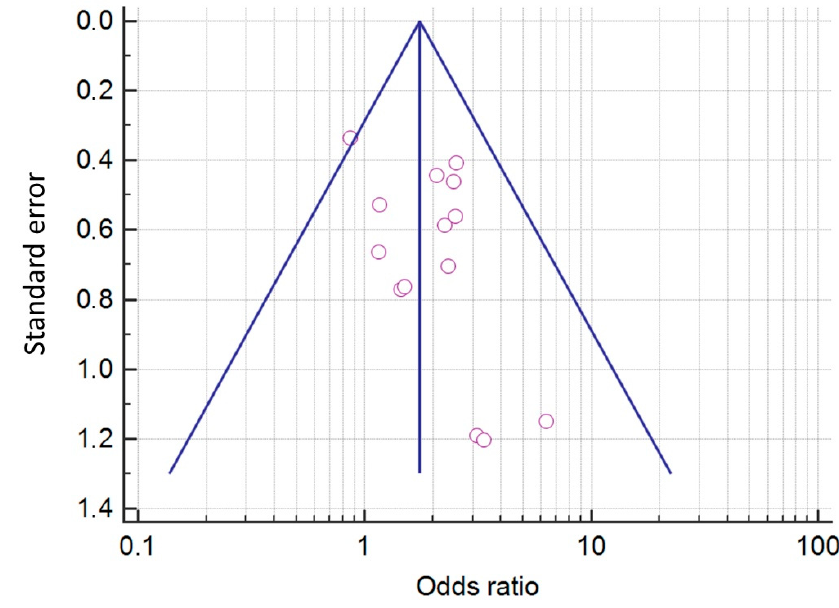
Figure 4. A funnel plot estimating the likelihood of a publication bias.